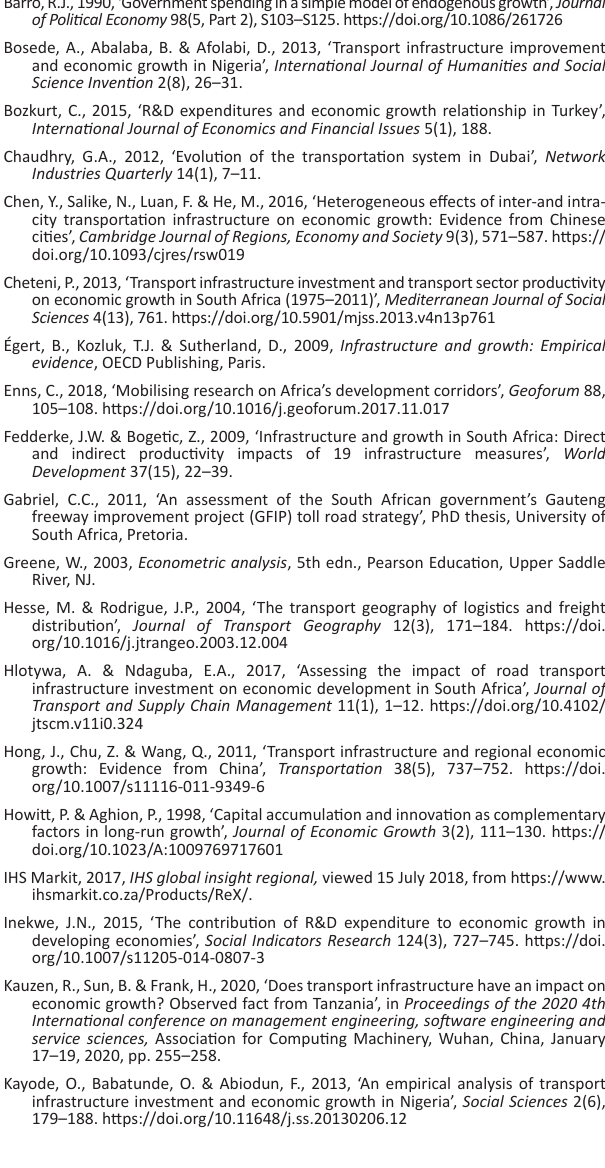
Figure 3. The Jarque Bera probability is 61.31166, which shows that the model is not normally